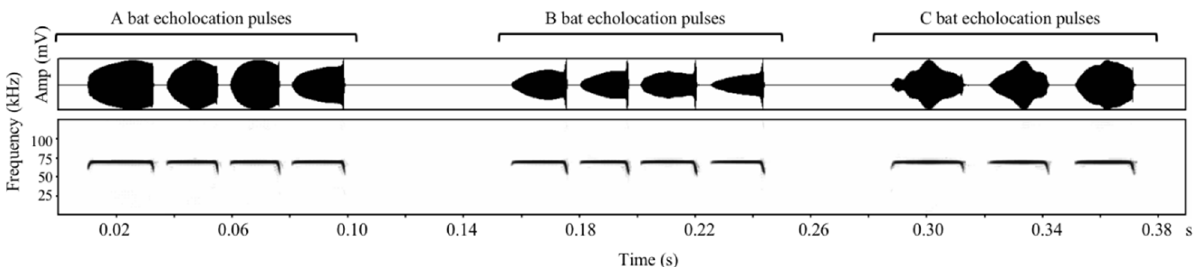
Figure 2. Spectrograms of a set of echolocation pulses from three different Rhinolophus ferrumequi- num individuals ( A – C ).